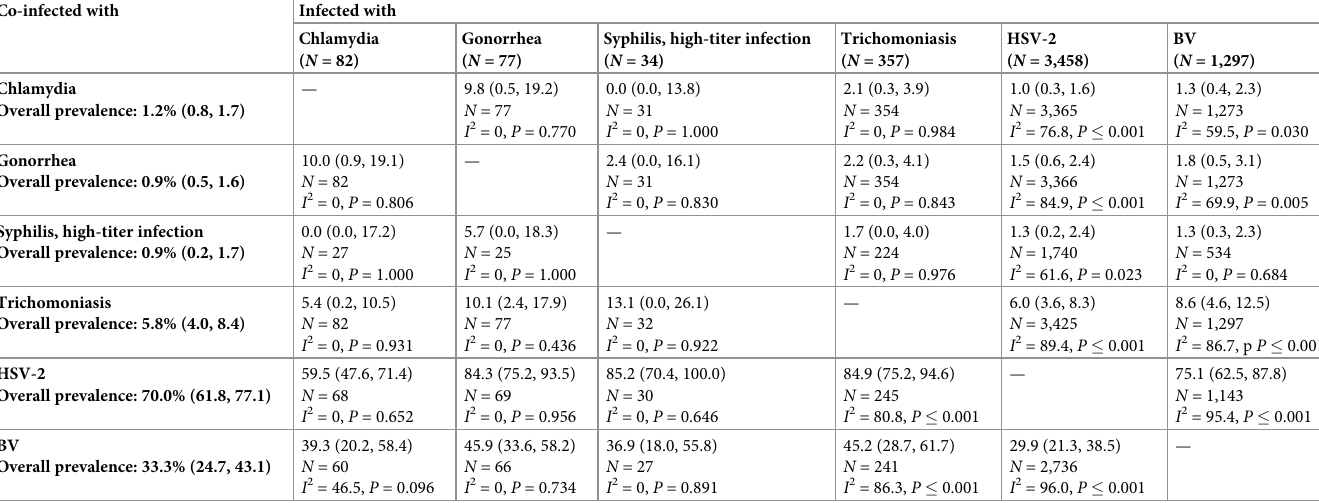
Table 7. Proportion of participants with each infection who are co-infected with an additional STI or BV among women aged 25–49 years in Southern/Eastern Afri- can clinic/community populations. Co-infected with Infected with